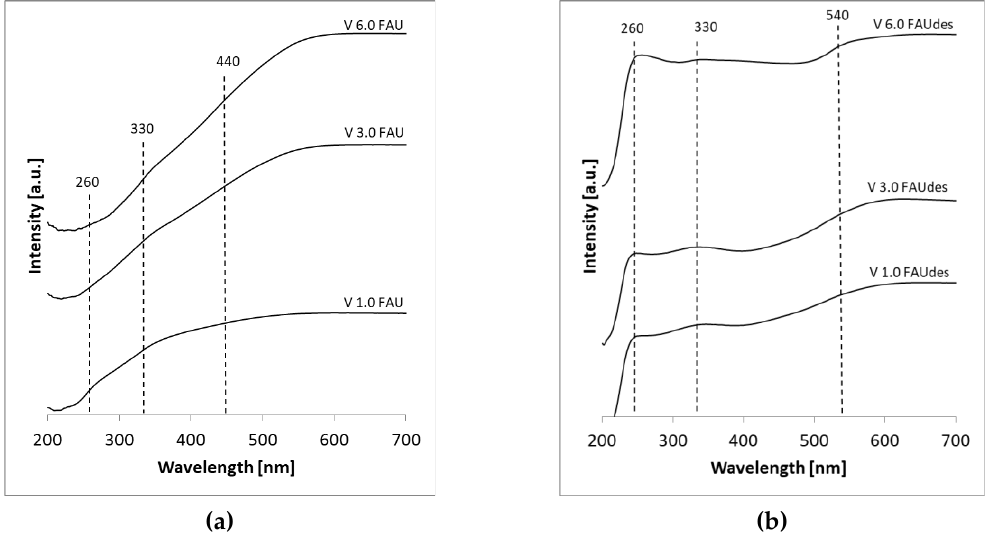
Figure 3. DR-UV-VIS spectra of the prepared V x FAU ( a ) and V x FAUdes ( b ) samples.